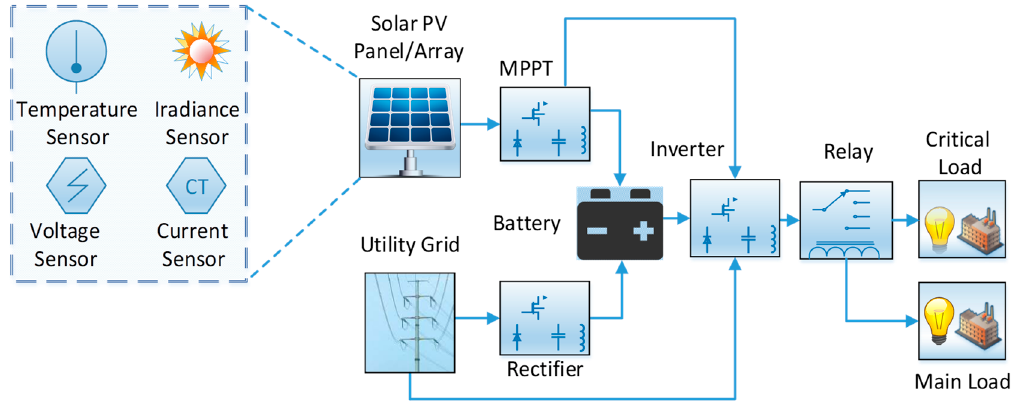
Figure 2. Proposed architecture for solar PV integration in intermittent grids.